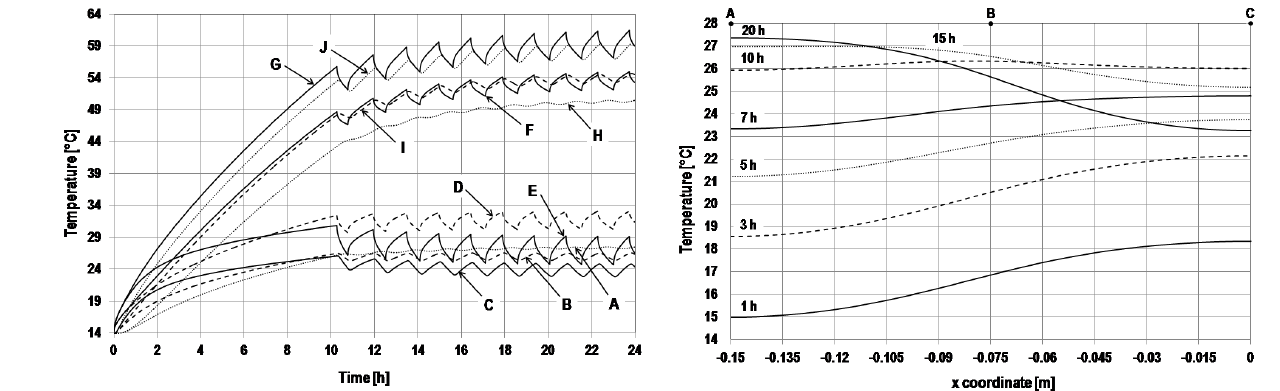
Figure 6: Temperature distribution on the floor surface y = 1.5 L at the selected time